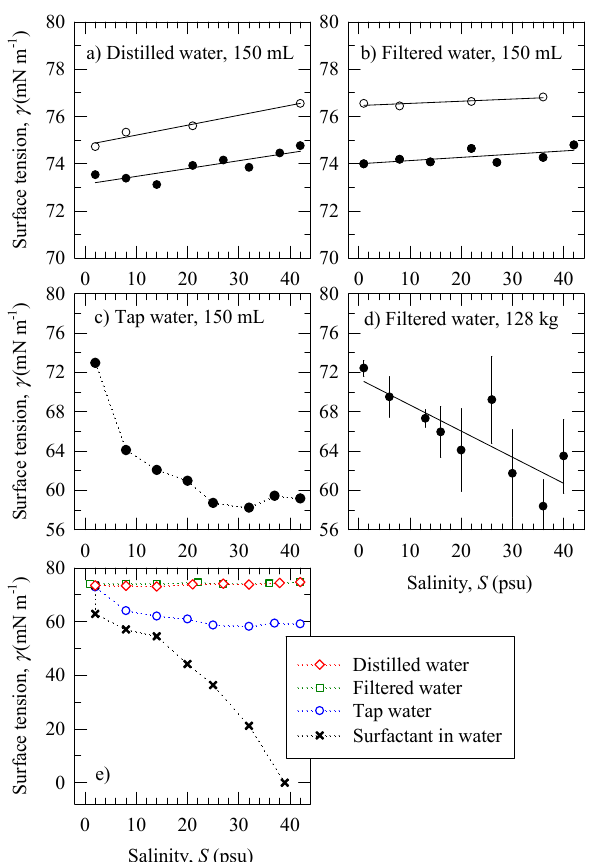
Figure 3. Trend of the surface tension γ as a function of salinity S for water with different quality in 150 mL volume: ( a ) distilled; ( b ) filtered; ( c ) tap; ( d ) filtered (large volume), error bars are ±95% CI; ( e ) data from panels ( a – c ) (open symbols) are compared to data for silicone oil (a surfactant) mixed in water (crosses); the legend lists all symbols in panel ( e ). Solid lines are linear fits to data. Dotted lines connect the data points. The solid and open symbols in panels ( a , b ) are for two different measurements of γ at same salinity values. (Note in panel d 128 kg = 128 × 10 3 mL.).